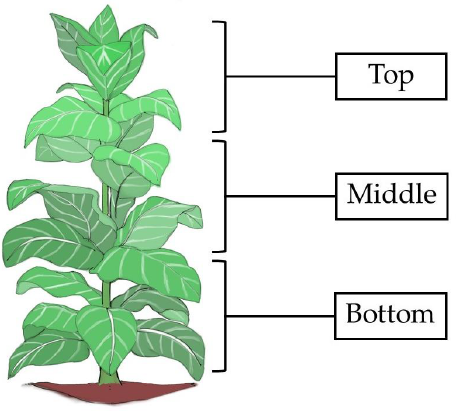
Figure 1. Burley tobacco plant variety showing approximate stalk position of farmers’ grades.